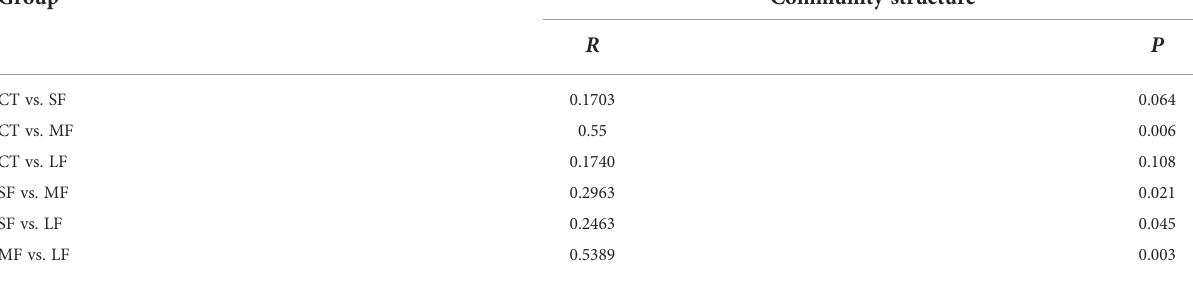
TABLE 2 ANOMIS results for the community structure of the gut microbiota (OTUs) of juvenile crabs at different levels of DTF (28°C, 28 ± 2°C, 28 ± 4°C, 28 ± 6°C) based on Bray-Curtis distances. Group